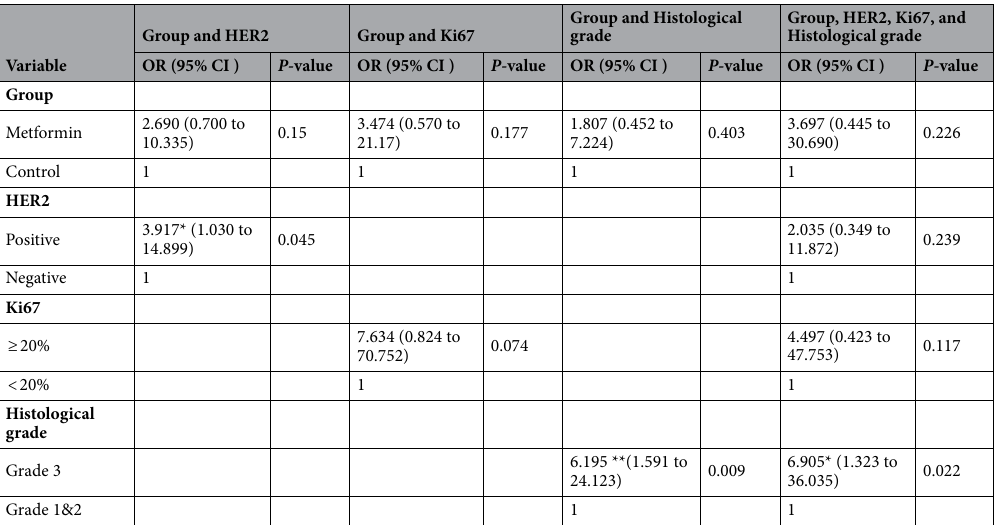
Table 3. Multivariate analysis of the factors associated significantly with pCR on the univariate level. OR Odds Ratio, HER2 human epidermal growth factor receptor 2, Ki67 proliferation index. *Significant as compared to the control group at P value ≤ 0.05, CI: 95% confidence interval. ** Significant as compared to the control group at P value ≤ 0.01, CI: 95% confidence interval.